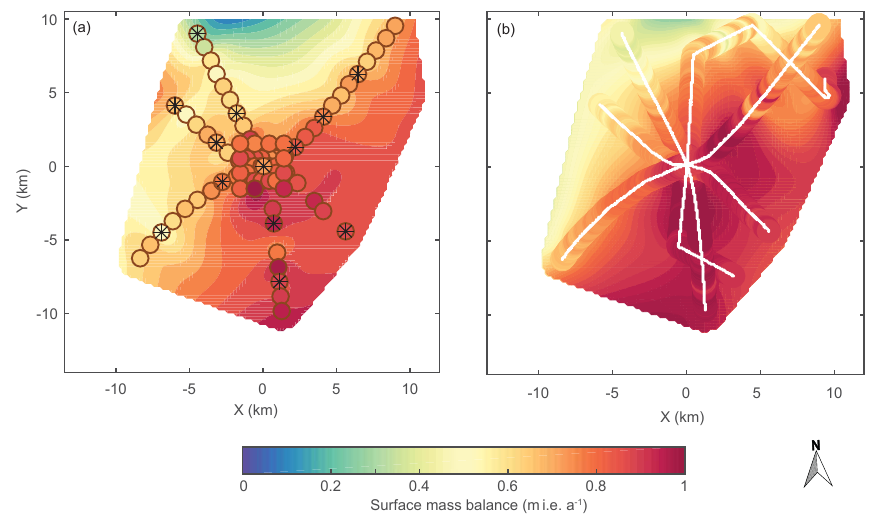
Figure 4. Surface mass balance (SMB). (a) SMB during 2013–2014 interpolated from stake measurements. Circles show the locations of the installed stakes. Wheel spokes inside of the circles show the locations of 13 surface-density measurements. (b) SMB over the past decade estimated from radar. It accounts only for the vertical variability of density. White curves show the location of radar profiles. The 23m long firn core was drilled near the crossover of all profiles at the